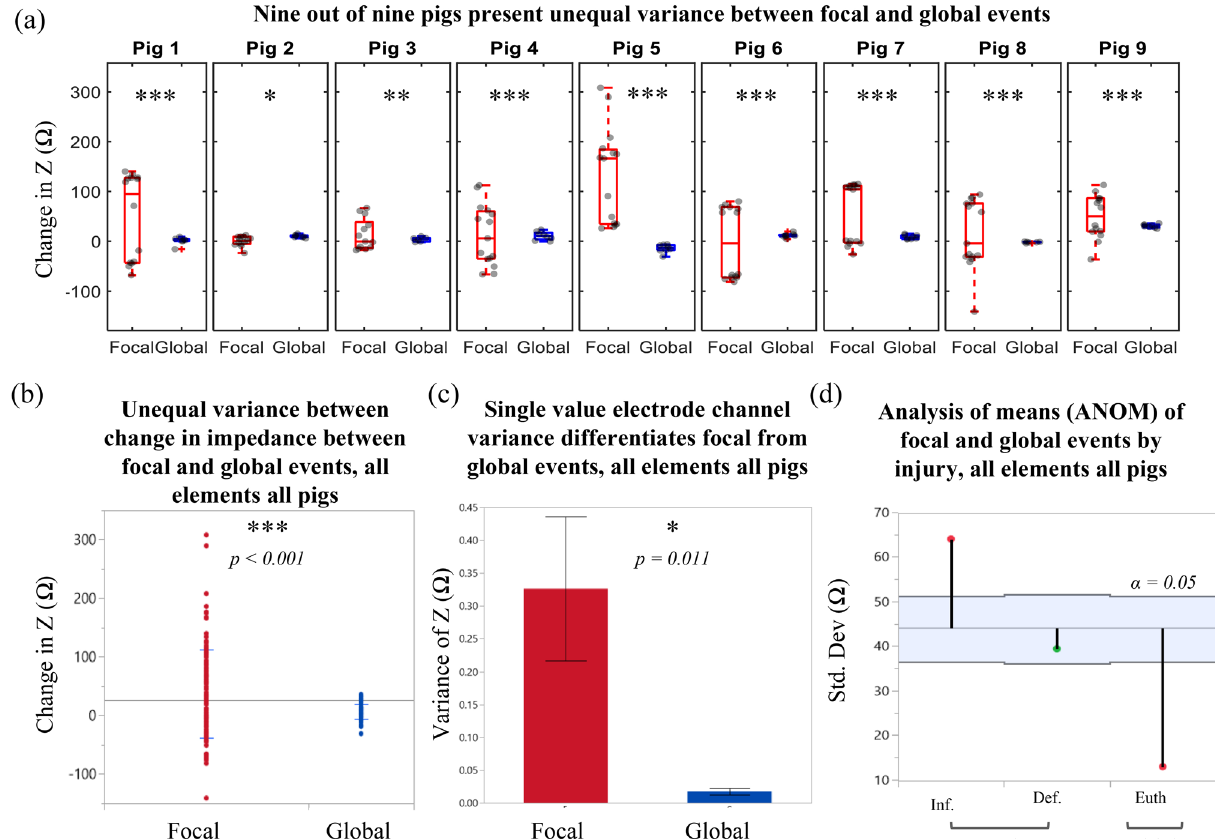
Figure 7. Focal versus global differentiation within and across pigs. ( a ) Change in impedance between focal (balloon volume change) and global (euthanasia induced brain death) intracranial events within each pig. Nine out of nine pigs showed significant difference in variance (Levene’s) between focal and global events (* p < 0.05; ** p < 0.01; *** p < 0.001). ( b ) Comparison of variance between change in Z for all elements within all pigs between focal and global events shows significant difference. ( c ) If all elements are averaged into a single-value variance within each pig for each event, the single value variance significantly differentiates focal from global injury (Welch’s t-test to account for unequal variance). ( d ) Analysis of means for the standard deviation of impedance change for each event of the protocol shows differentiating trends and significant differences from the